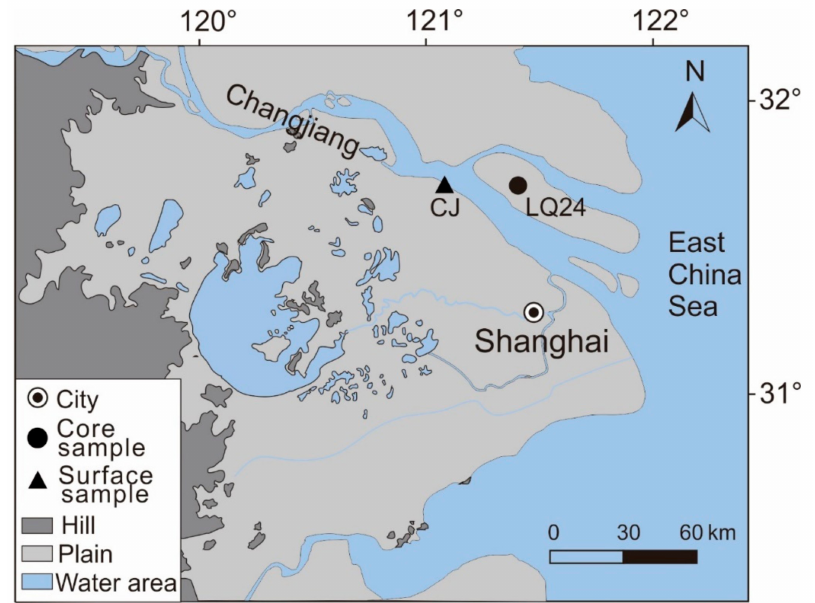
Figure 3. Sampling locations of the core and modern Changjiang River